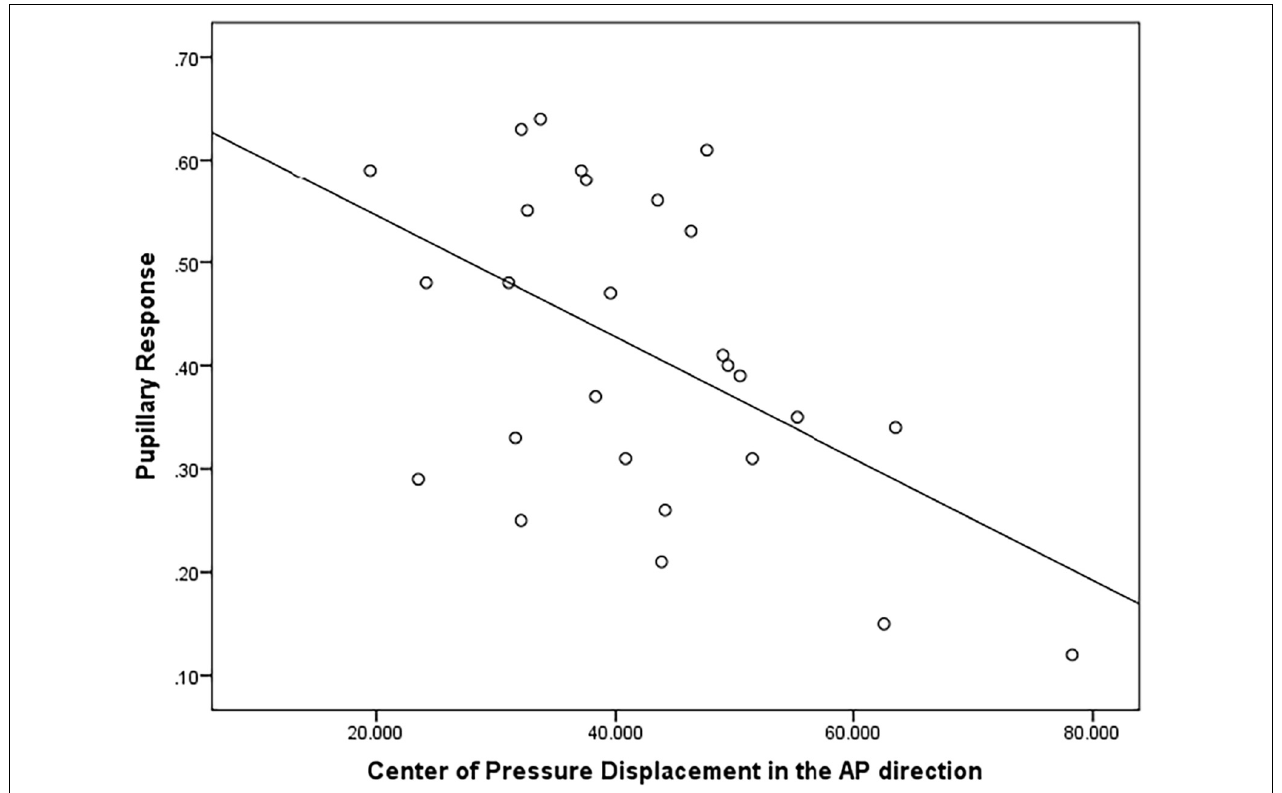
FIGURE 4 | Correlation analysis between pupillary response and Center of Pressure (CoP) displacement (in mm 2 /s) in the Anterior-Posterior direction in healthy